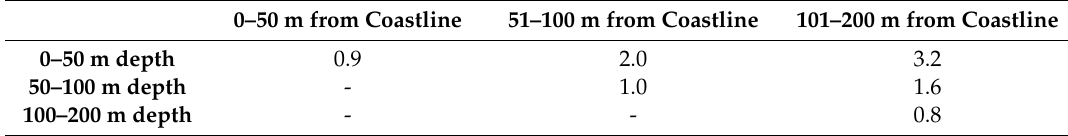
Table 1. The vertical water speed profile, presented in [34].